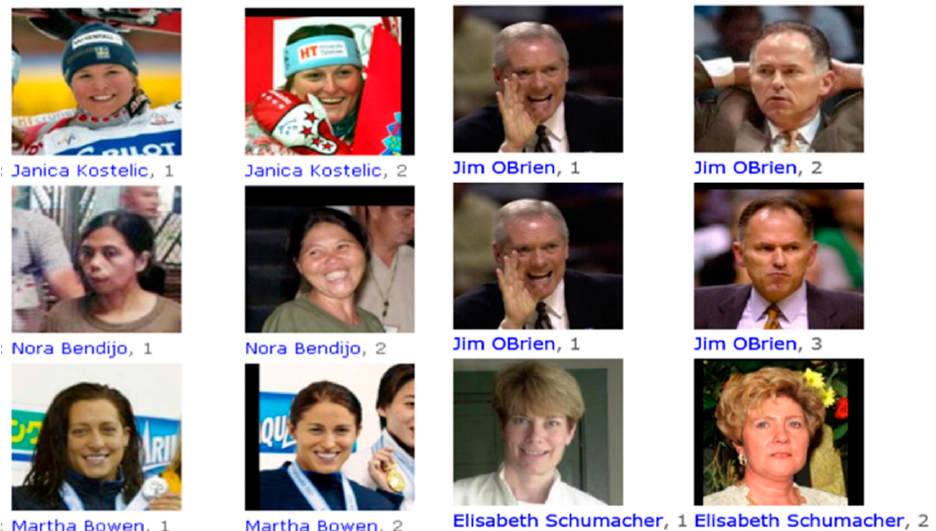
Figure 5. Labeled Faces in the Wild (LFW) dataset images and labels [6,17].